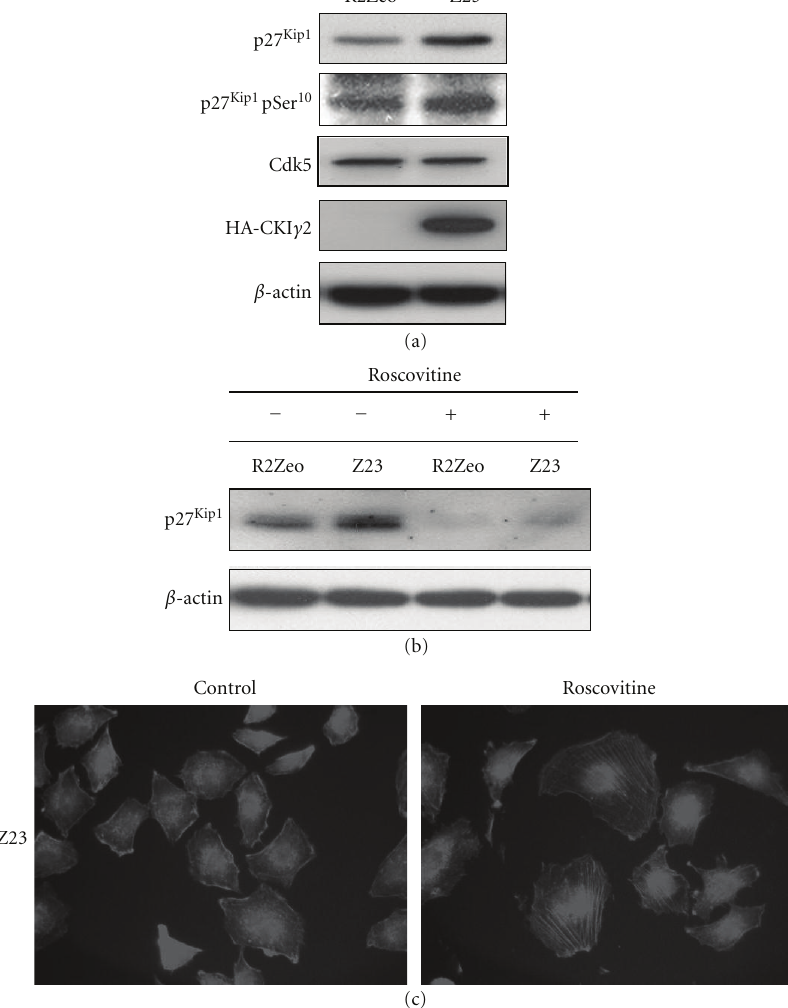
Figure 12: Roscovitine reverses the e ff ects of CKI γ 2 overexpression on p27 Kip1 and actin stress fibers. (a) From indicated cell lines, equivalent amount of total cell lysate proteins was subjected to Western Blot analysis using specific antibodies against total and phospho-Ser 10 p27 Kip1 , Cdk5, and HA. β -Actin was used as loading control. (b) Equivalent amount of total cell lysate proteins from indicated cells treated or not with roscovitine that were subjected to Western Blot analysis using specific antibodies against p27 Kip1 or β -actin was used as loading control. (c) Cells overexpressing CKI γ 2 were incubated with roscovitine (25 μ M, 16hrs) before to be stained with phalloidin to visualized actin organization. Images were taken at